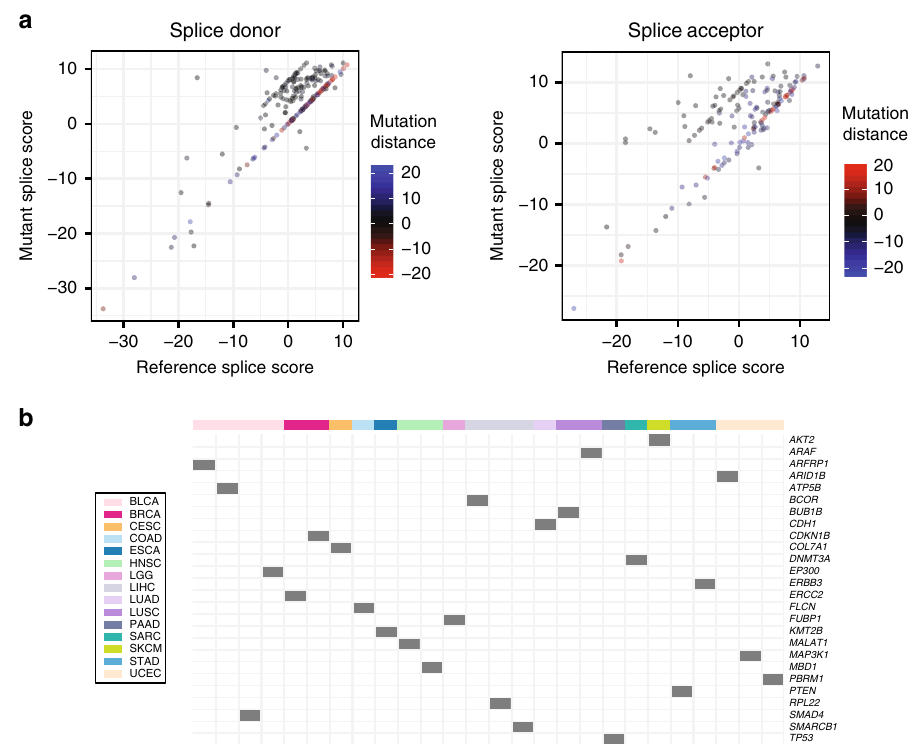
Fig. 5 Characterization of nc-SCMs from TCGA WES data. a Comparison of splice scores between the reference and mutant for donors and acceptors. The color indicates the mutation distance to the junction. b nc-SCMs found in cancer-related genes across different cancer types. Source data are provided as a Source Data fi